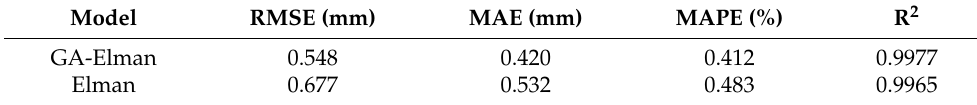
Table 3. Performance evaluation of test set prediction using GA-Elman model. Model